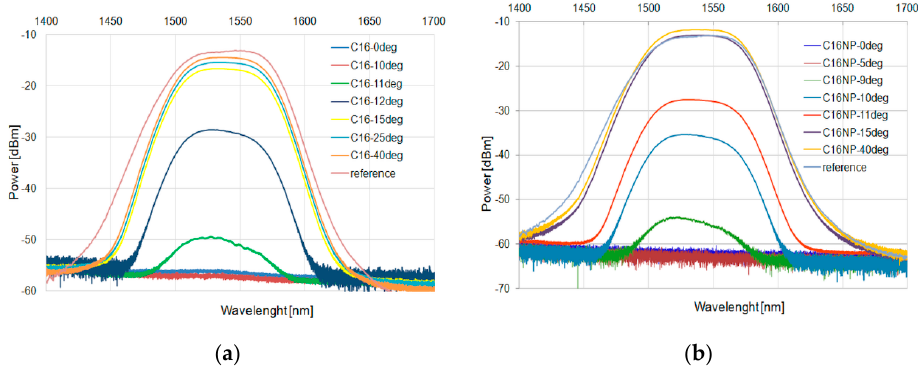
Figure 12. Cooling process in C16 ( a ) and with an admixture of NPs ( b ) for SLED 1400–1700 nm.